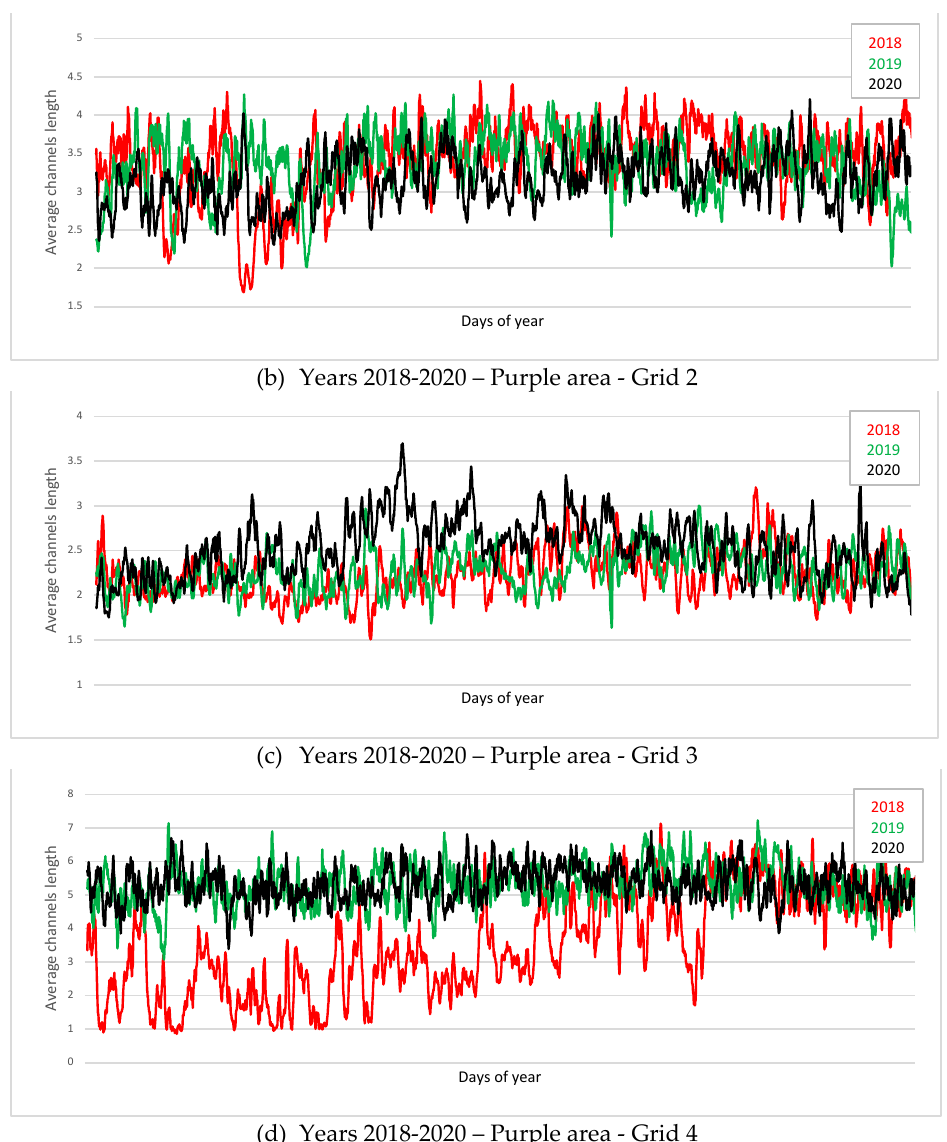
Figure 13. Results corresponding to the average length of channels constituted from 2018 to 2020 in the purple geographical area under study.